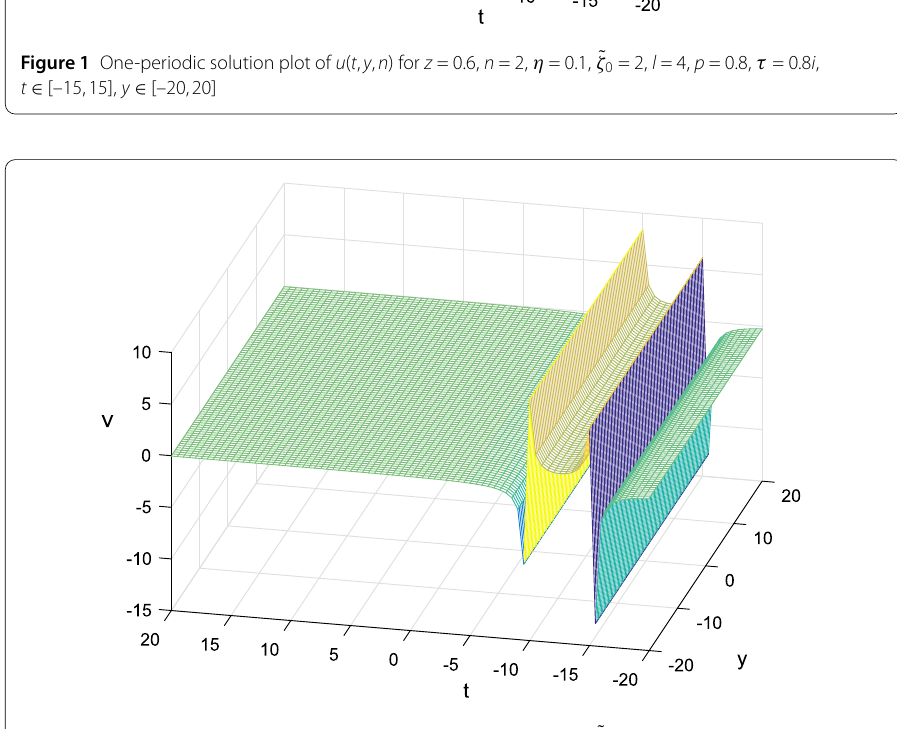
Figure 2 One-periodic solution plot of v ( t , y , n ) for z = 0.6, n = 2, η = 0.1, ˜ ζ 0 = 2, l = 4, p = 0.8, τ = 0.8 i , t ∈ [–15,15], y ∈